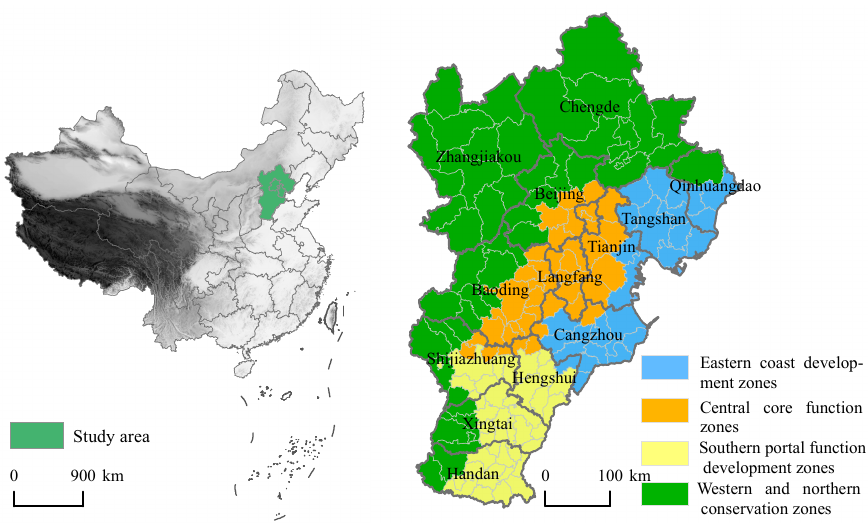
Figure 1. Overview map of the Beijing–Tianjin–Hebei region.